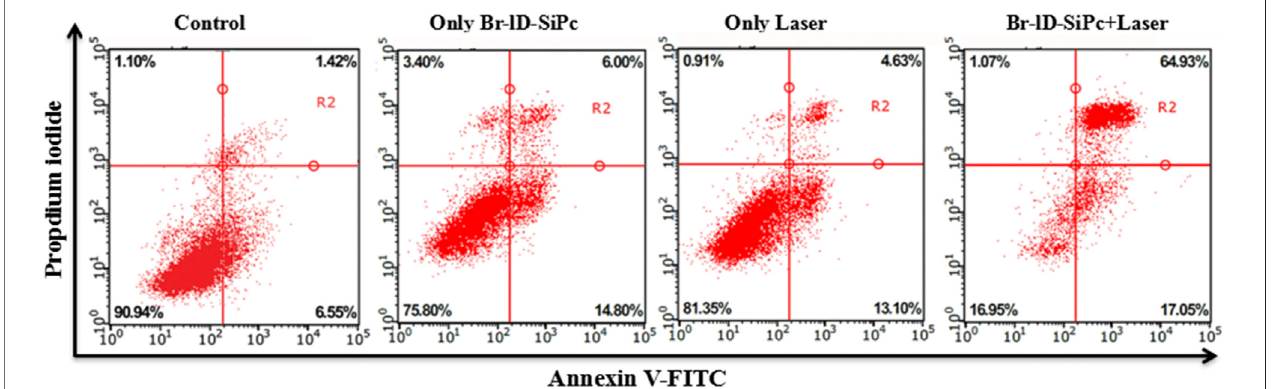
FIGURE 6 | Assessment of apoptosis in HO-8910 cells after treatments with Br-ID-SiPc or/and laser.